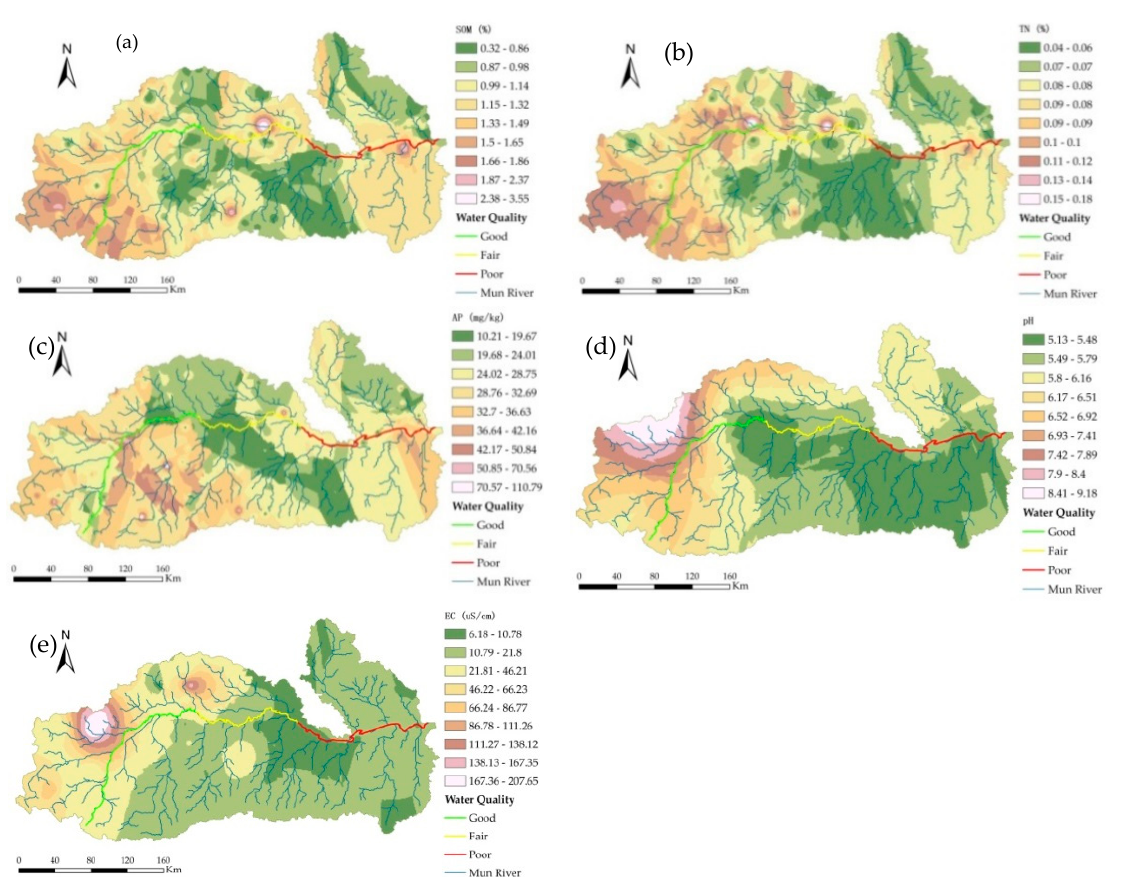
Figure 9. Spatial patterns of ( a ) SOM, ( b ) TN, ( c ) AP, ( d ) pH, and ( e ) EC in the rainy season.